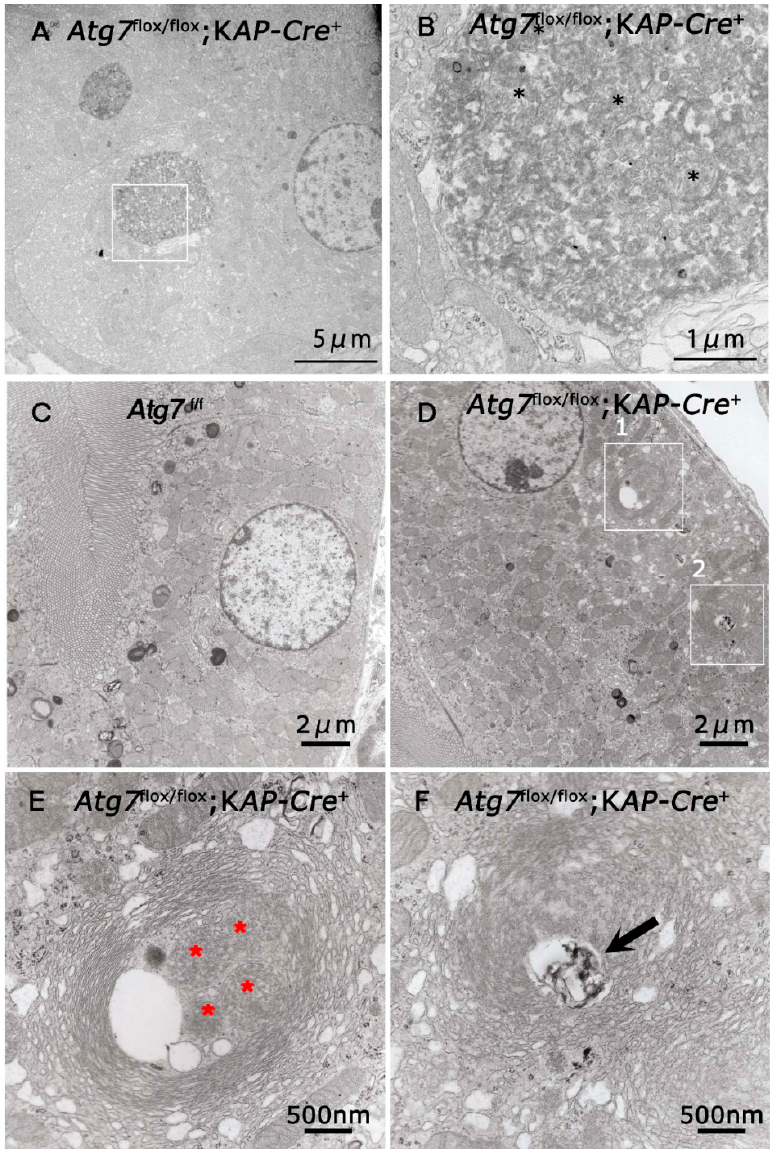
Figure 5. Electron microscopic analyses of Atg7 deficient renal proximal tubular cells. The renal proximal tubular cells of 2-month-old Atg7 flox/flox ;KAP-Cre + ( A , B , D – F ) and Atg7 flox/flox ( C ) mice were investigated with a transmission electron microscopy. ( B ) is higher magnification of area. Black asterisks indicated degenerated mitochondria. ( A ) (white box). ( E , F ) are higher magnification of areas (white boxes 1 and 2, respectively) in ( D ). Asterisks in ( E ) indicated peroxisome-like structures in the multi-lamellar bodies. Arrows indicate lysosome like structures in the multi-lamellar bodies.